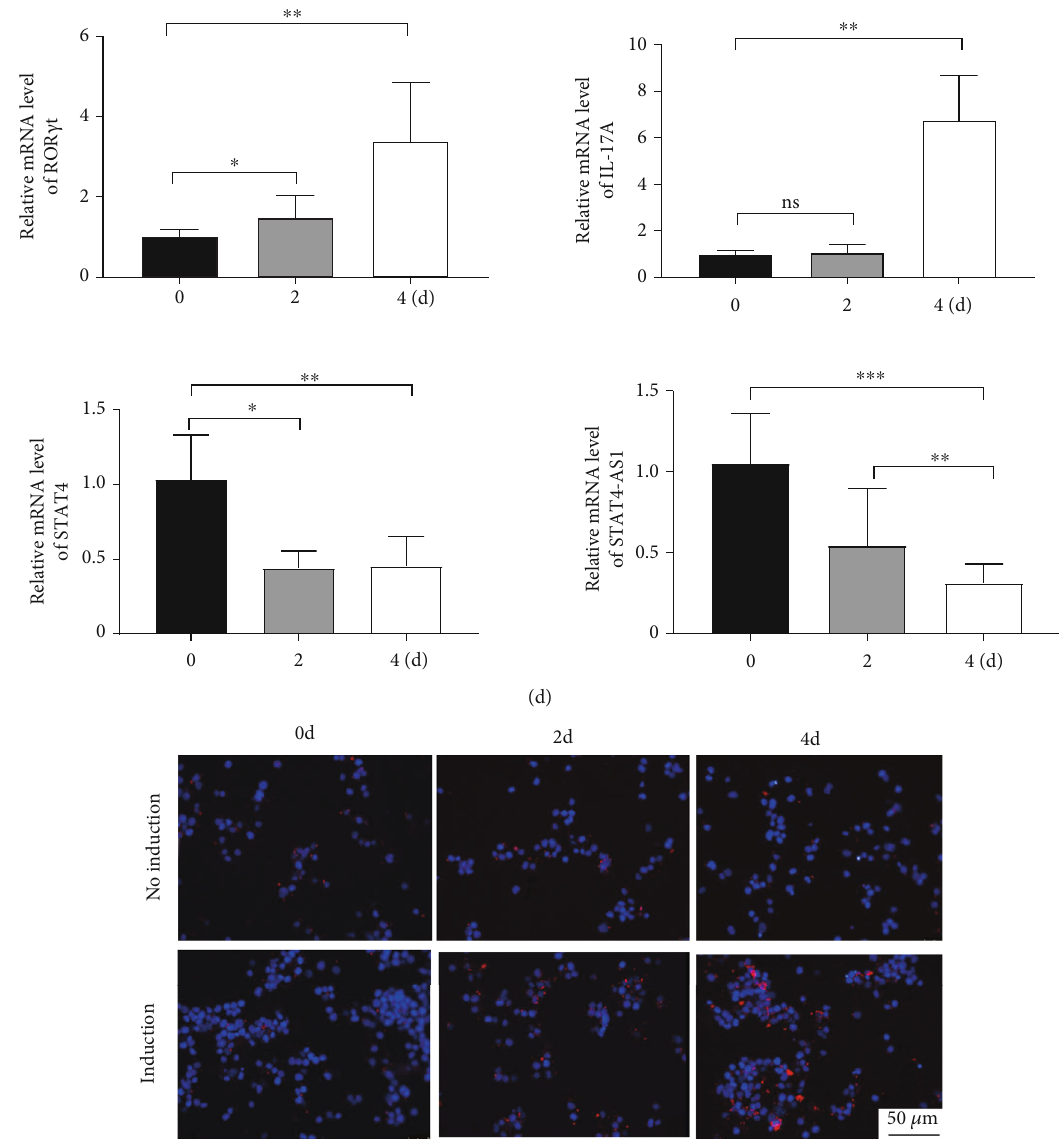
Figure 2: lncRNA STAT4-AS1 expression was downregulated accompanied by upregulation of IL-17 expression in PBMCs. (a) The proportion of TH17 cells on day 0 and day 3 of induced di ff erentiation. Flow cytometry fi gures (left) and statistical analysis (right) of TH17 cells. (b) The upper chart of this panel shows genome organization of the stat4 gene at locus 2q32.2-q32.3. The chart shows the start and end positions of these genes as indicated on the UCSC site. Black arrows indicate transcription direction, green blocks are the exons of STAT4, and purple blocks are the exons of STAT4-AS1. The lower chart of this panel shows that the exons of STAT4 and STAT4-AS1 have an overlapping region (OL). Blocks with colors (orange, blue, and red) represent exons. Red block in STAT4 represents the 23 exon and also OL region. The genomic organization of the human STAT4-AS1 locus. “ + ” at both sides of strand represents the positive strand; “ - ” represents the negative strand. (c) The levels of IL-17A in cell supernatant were detected using ELISA. (d) The expression of IL-17A, lncRNA STAT4-AS1, STAT4, and ROR γ t genes was detected using qPCR, respectively. (e) The expression of intracellular ROR γ t protein was detected using immuno fl uorescence. Three independent experiments were performed, and data are presented as the mean ± SD . ∗ p < 0 : 05 , ∗∗ p < 0 : 01 , and ∗∗∗ p < 0 : 001